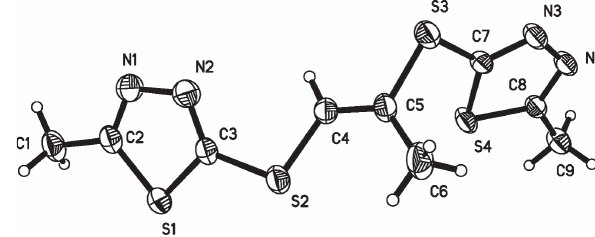
Table 1: Data collection and handling.